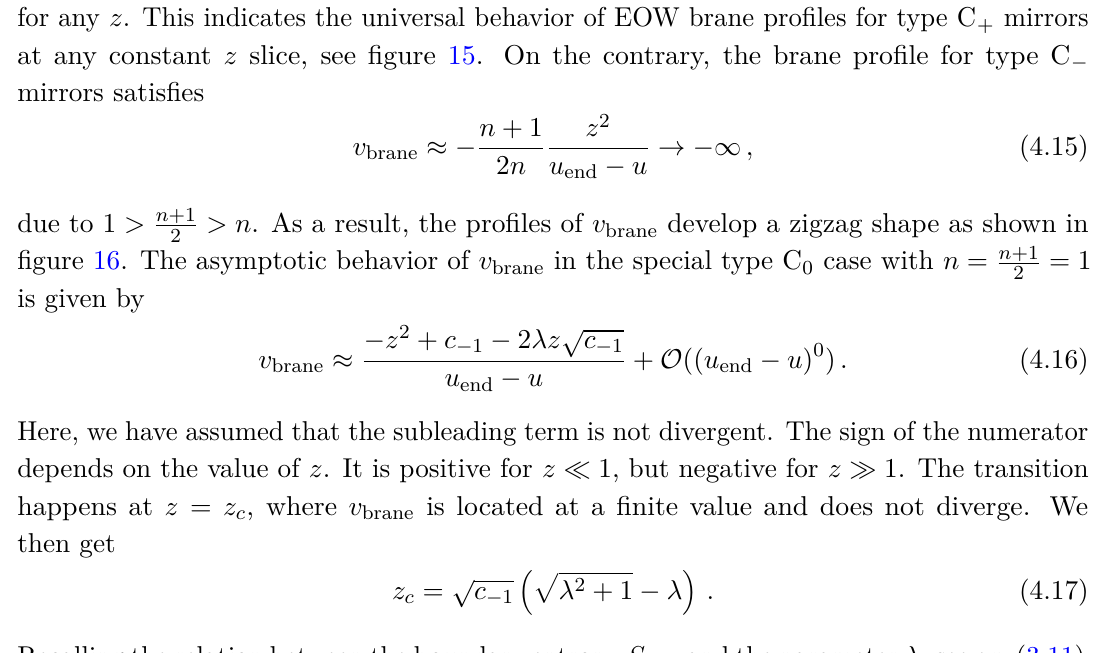
for any z . This indicates the universal behavior of EOW brane profiles for type C